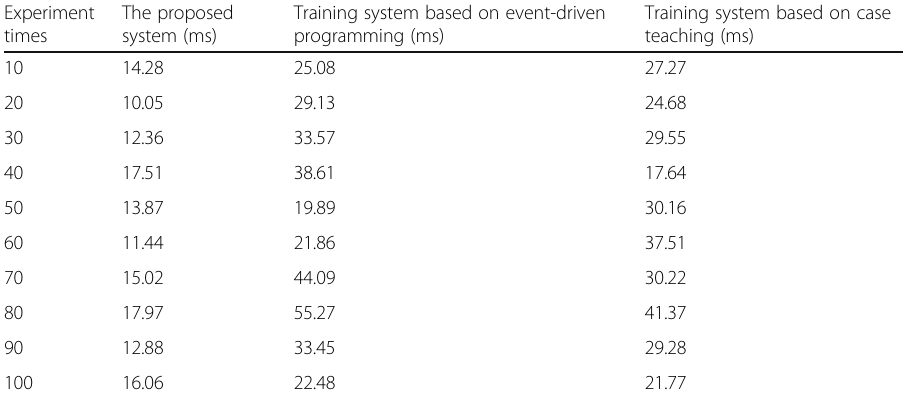
Table 1 Transmission delay of different training systems (ms) Experiment